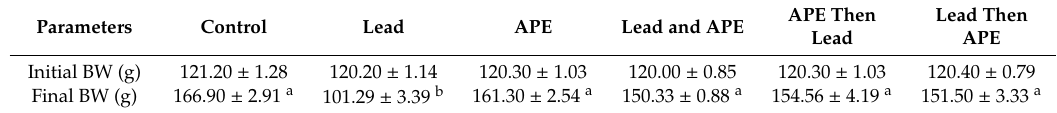
Table 2. Initial and final body weights of rats of all experimental